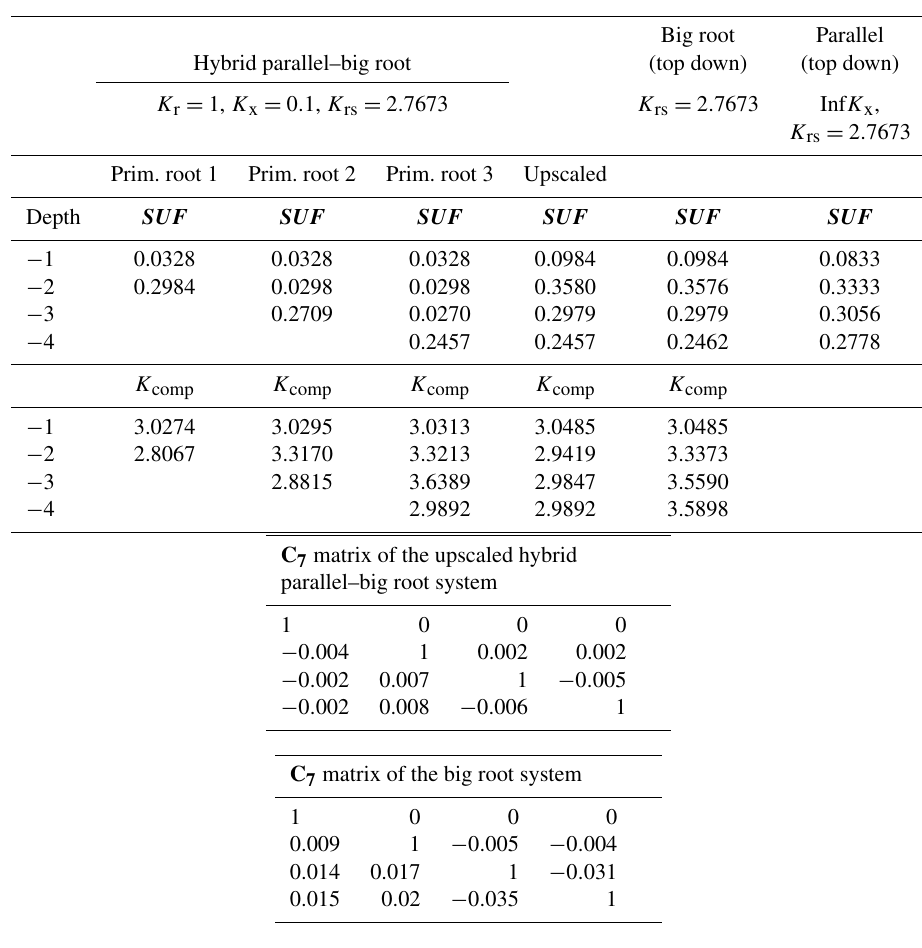
Table 3. K rs , SUF , K comp , and upscaled values and C 7 matrices for the hybrid parallel–big root system with variable root radial root segment conductances along the roots ( K r = 0 . 1 along roots, except at root tip K r = 1) for the big root system and for the parallel root system (with infinite K x ) using top-down